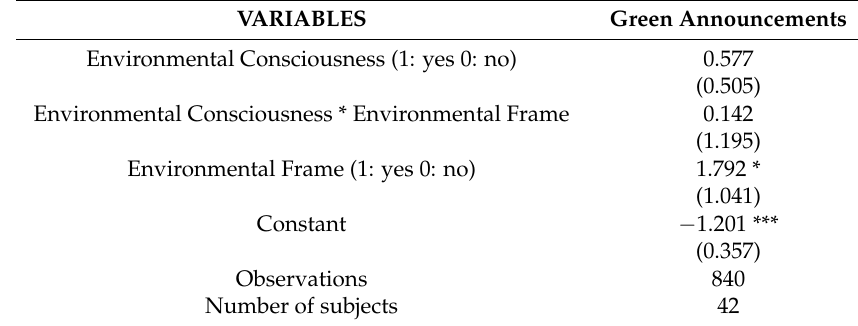
Table 7. Panel data Logit model for the probability of announcing green goods.